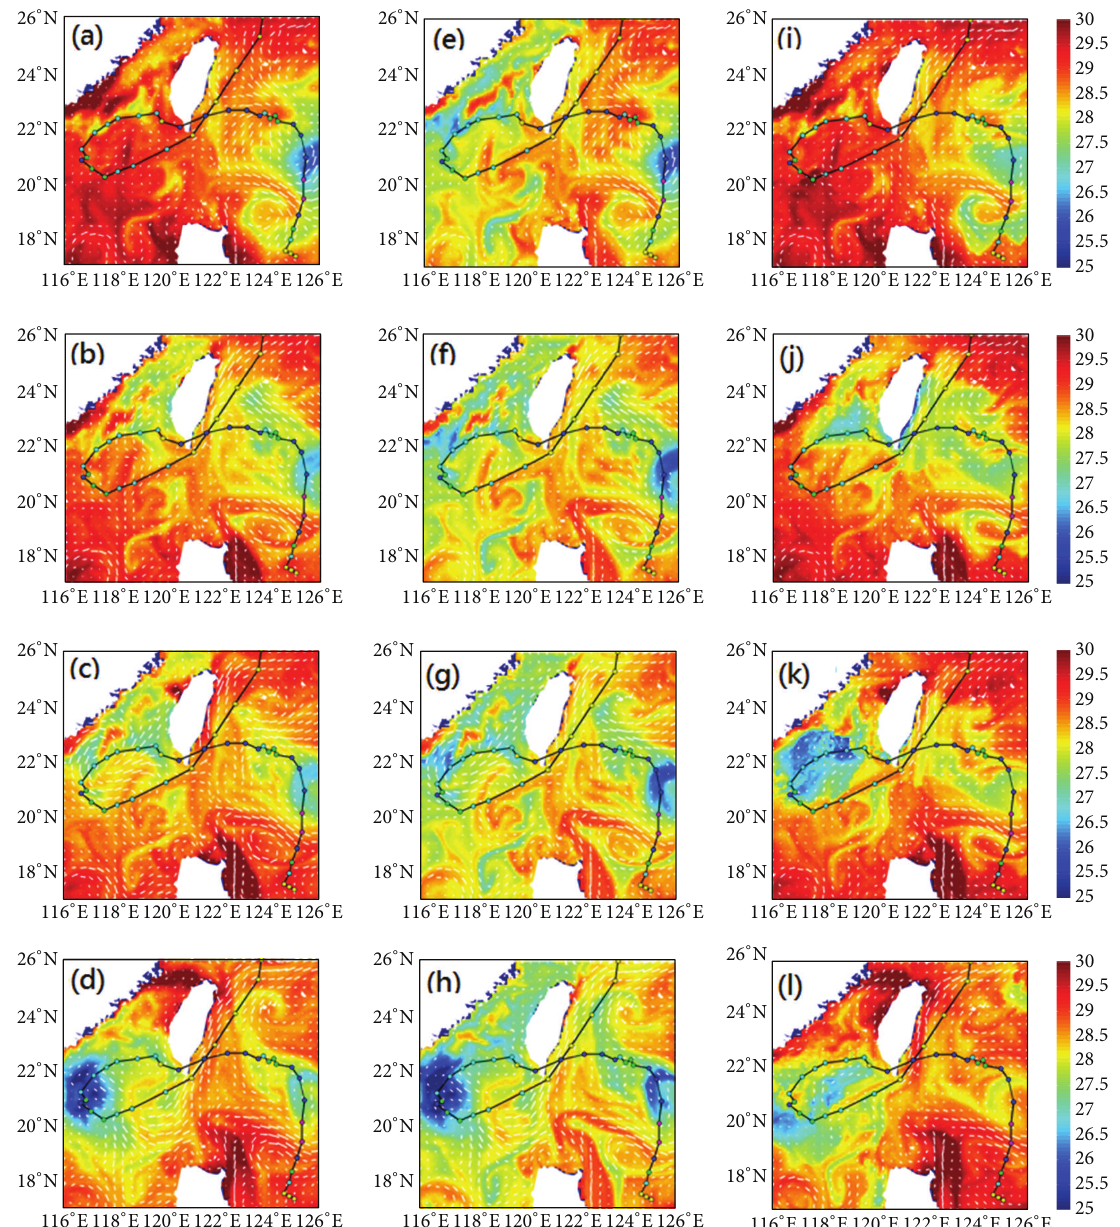
Figure 4: (a)–(d) ROMS simulated SST (unit: degree C) during the intensification of Tembin (23 August, 25 August, 26 August, and 28 August) in EXPstd. (e)–(h) Same as (a)–(d) but for EXP1. (i)–(l) Same as (a)–(d) but for